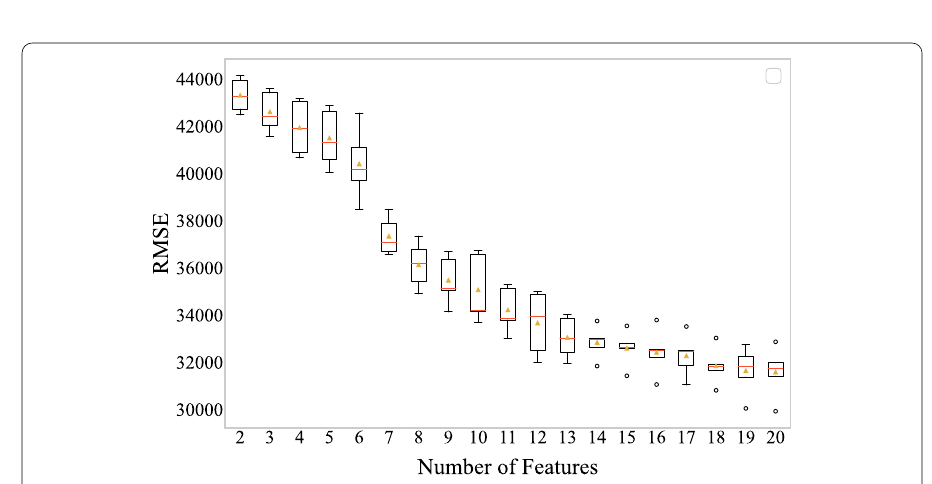
Fig. 10 Recursive feature elimination of gradient boosting model for the 20 most important